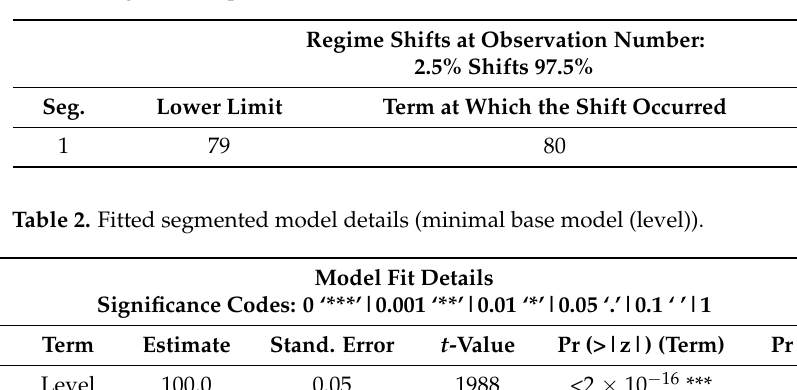
Table 1. Regime shift points.